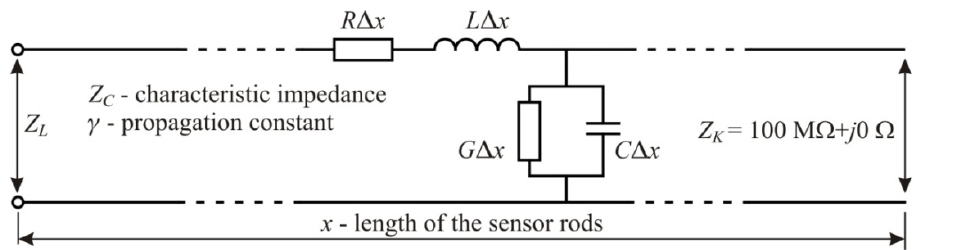
Figure 6. Sensor rods as a transmission